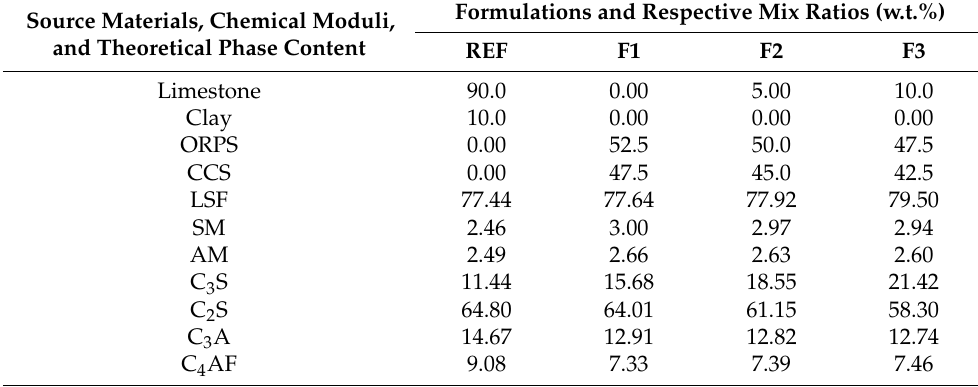
Table 1. Experimental clinkers and mix